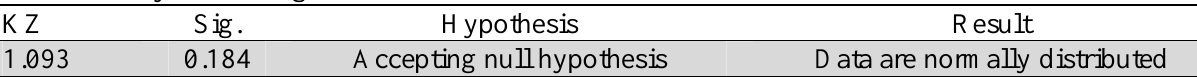
The summary of Kolmogorov–Smirnov test KZ Sig. Hypothesis Result 1.093 0.184 Accepting null hypothesis Data are normally